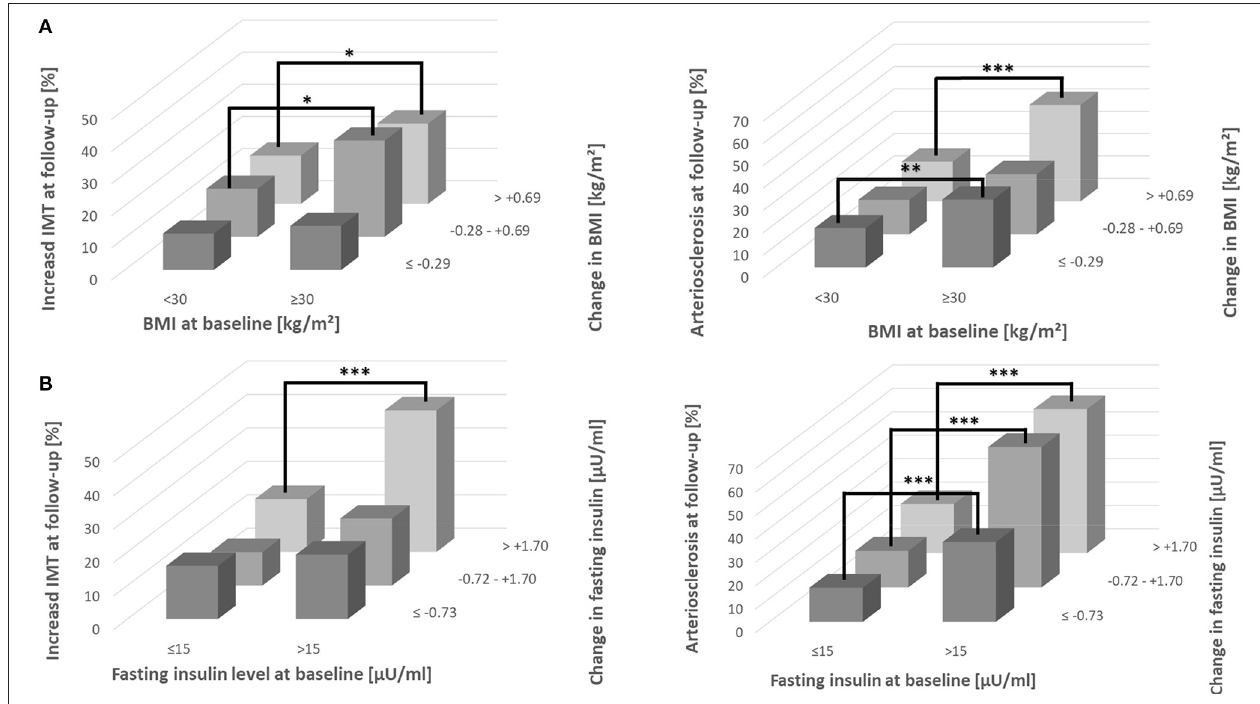
FIGURE 2 | Incidence of increased IMT and arteriosclerosis in subgroups defined by BMI (A) or fasting insulin (B) . Participants were stratified into subgroups defined by obesity (BMI: ≥ 30 kg/m ² ) or hyperinsulinemia (fasting insulin: > 15 µ U/ml) and tertiles of BMI or fasting insulin change during follow-up. Differences in distribution were analyzed using Chi-square test. *** p < 0.001; ** p < 0.01; * p < 0.05; IMT, intima media